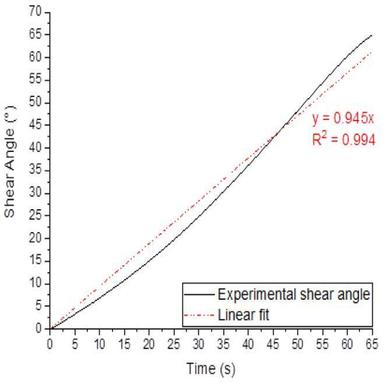
Experimental evolution of the shear angle with time for a bias-extension test performed with a crosshead speed of 1 mm/s (adapted from Pasco et al. \).